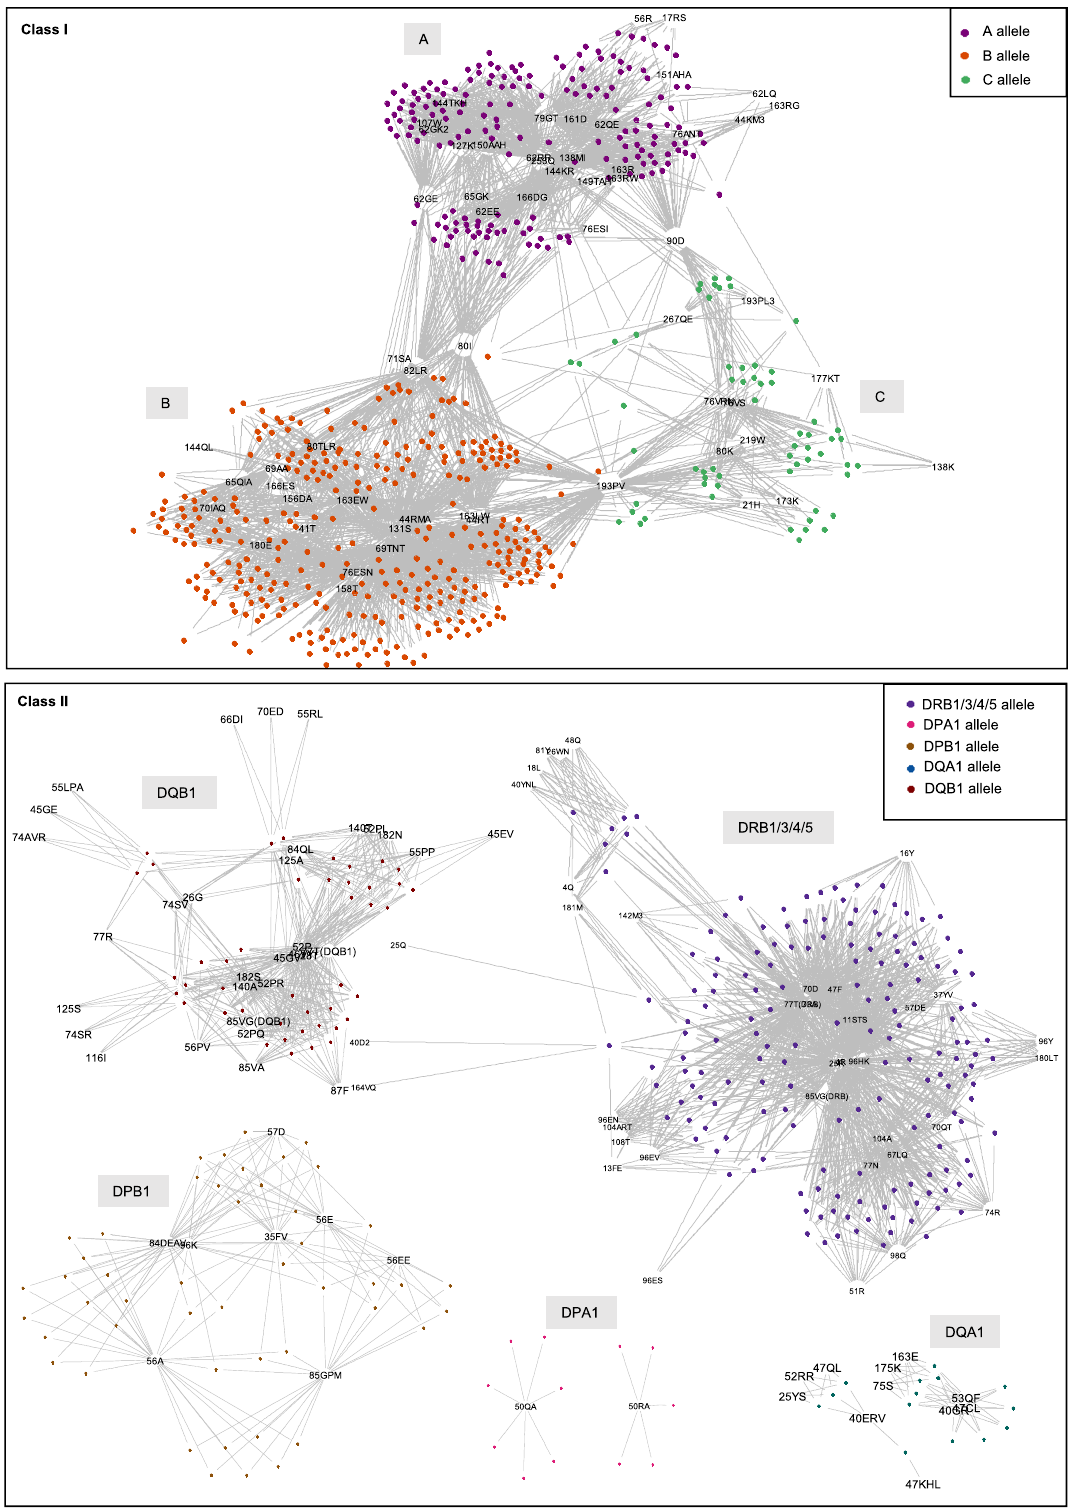
Fig. 2 Networks 44 of the complete library of HLA alleles and their associated eplets present in HLAMatchmaker v02 for HLA class I genes and v02.2 for HLA class II genes. Each node represents an allele and the lines connect them to eplets, showing that that allele expresses that eplet. Alleles are color- coded by gene. Interactive visualizations of the networks can be accessed at